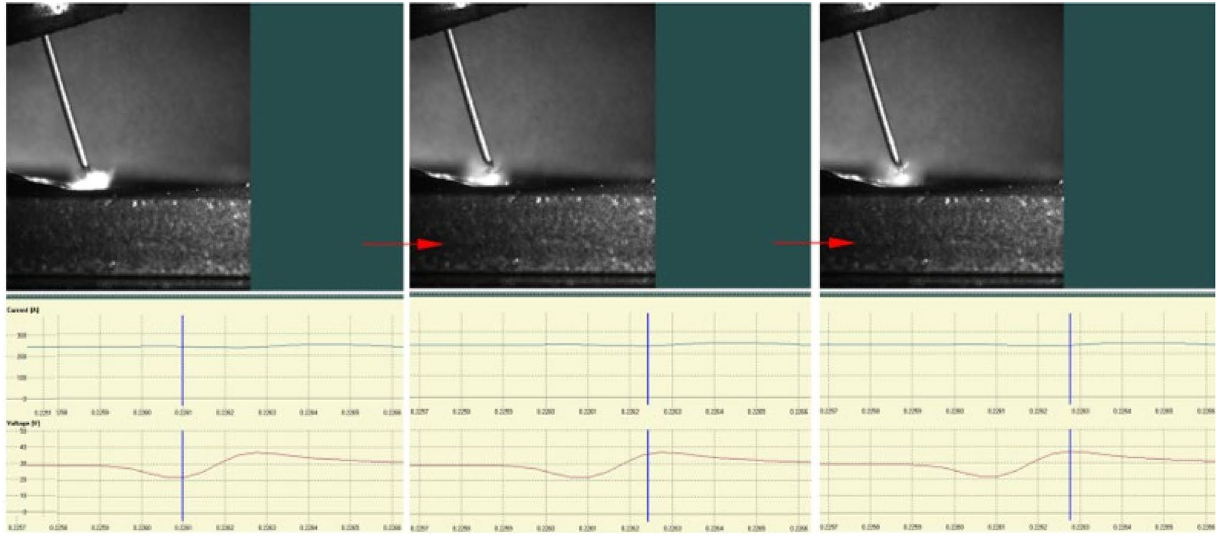
Fig. 11 Timeline and appearance of explosion from start to